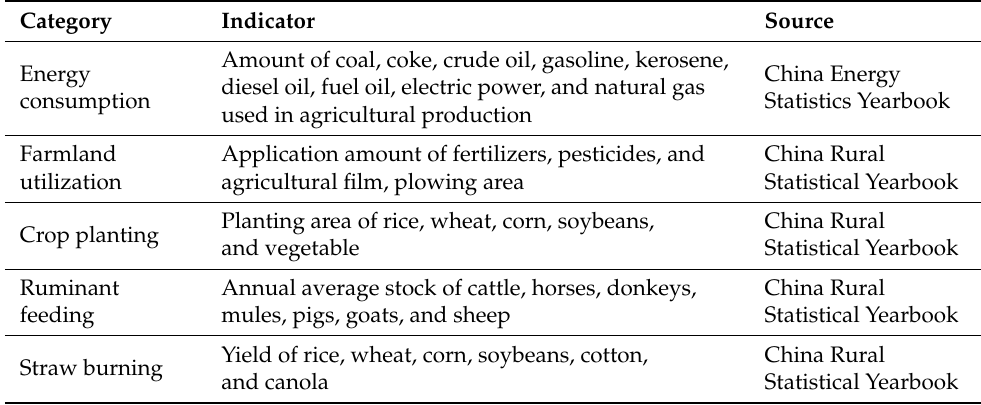
Table 1. Activity data description.